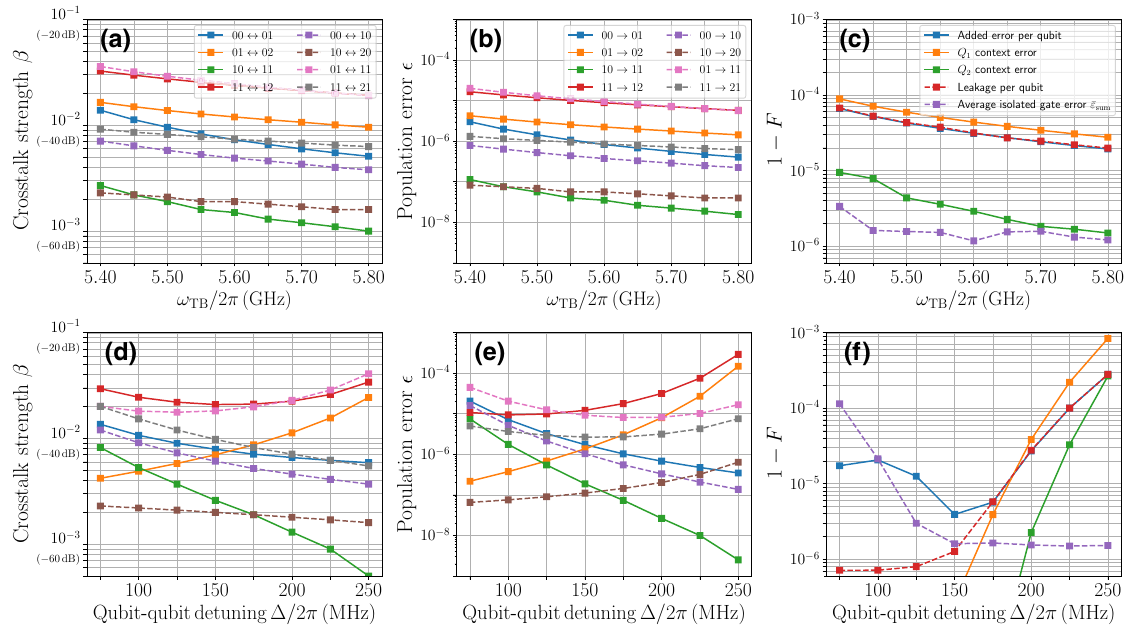
FIG. 4. (a)–(c) Dressing induced cross-driving effect between coupled qubits Q 1 ( 2 ) versus bus frequency with other system param- eters the same as those used in Fig. 1. (d)–(f) Cross-driving effect versus qubit-qubit detuning (cid:6) with bus frequency ω TB / 2 π = 5.650 GHz and qubit frequency ω 1 / 2 π = 5.000 GHz. Other system parameters are the same as in Fig. 1. For coupled qubits Q 1 ( 2 ) , when a microwave driving with strength (cid:7) is applied to one qubit, the nearby qubit can also be felt by driving with amplitude ˜ (cid:7) (i.e., cross driving), which is dependent on qubit states. (a),(d) Crosstalk strength between coupled qubits, defined as β ≡ ˜ (cid:7)/(cid:7) . Here, 0 j ↔ 0 k and 1 j ↔ 1 k label the cross driving applied on the transition | j (cid:2) ↔ | k (cid:2) of Q 2 with Q 1 in its ground state and excited state, respectively. Similarly, j 0 ↔ k 0 and j 1 ↔ k 1 label the cross driving applied on the transition | j (cid:2) ↔ | k (cid:2) of Q 1 with Q 2 in its ground state and excited state, respectively. (b),(e) Worst-case population error caused by cross driving. Here, 0 j → 0 k (1 j → 1 k ) labels the worst-case population on | k (cid:2) of Q 2 , where Q 2 is prepared in state | j (cid:2) and the Q 1 is in its ground state (excited state). (c),(f) Single-qubit gate error (1 − F ) under the influence of the cross-driving effect between